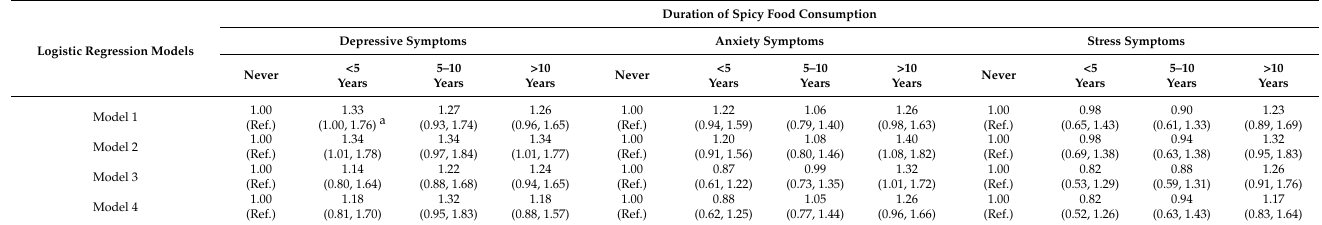
Table 4. Regression coefficients (95% CI) for psychological health by the duration of spicy food consumption among Chinese college